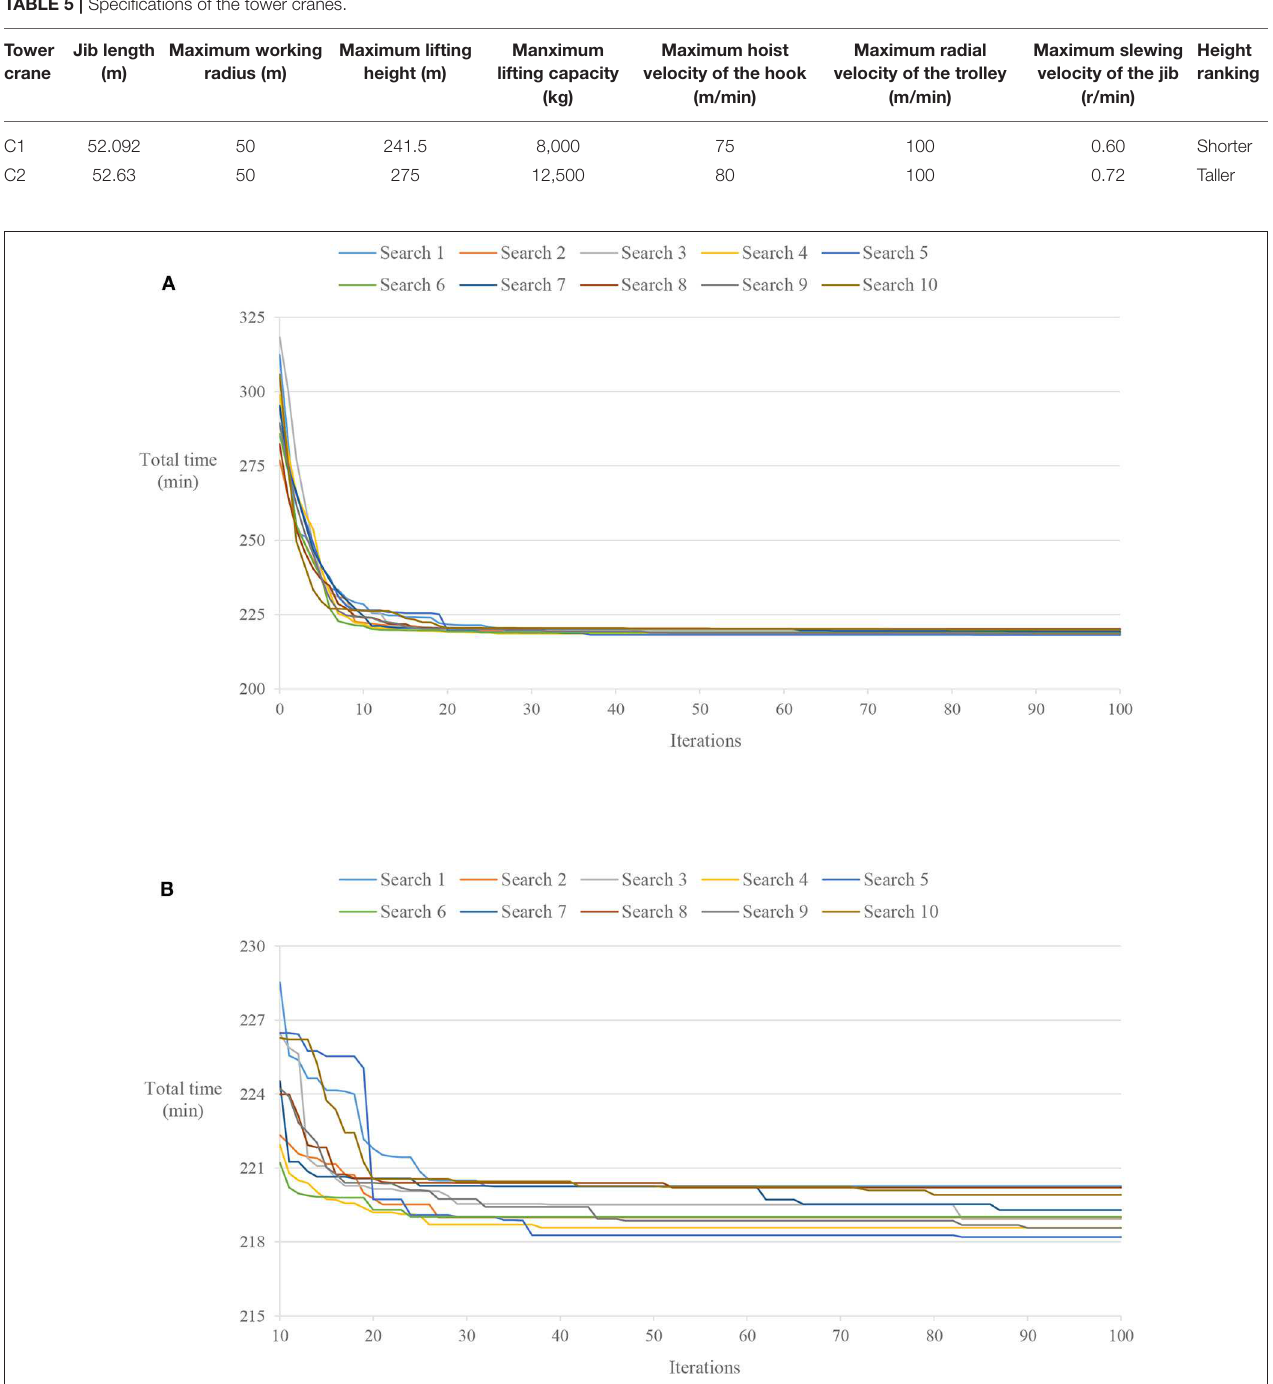
FIGURE 4 | Complete (A) and close-up (B) views of the convergence processes for 10 searches.